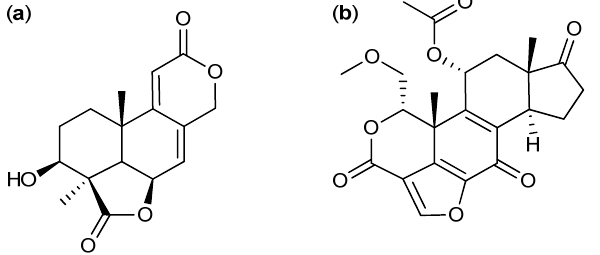
Figure 20. ( a ) Wentilactone B and ( b ) Wortmannin.